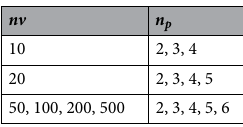
Table 7. Generation of ( nv , n p ) .